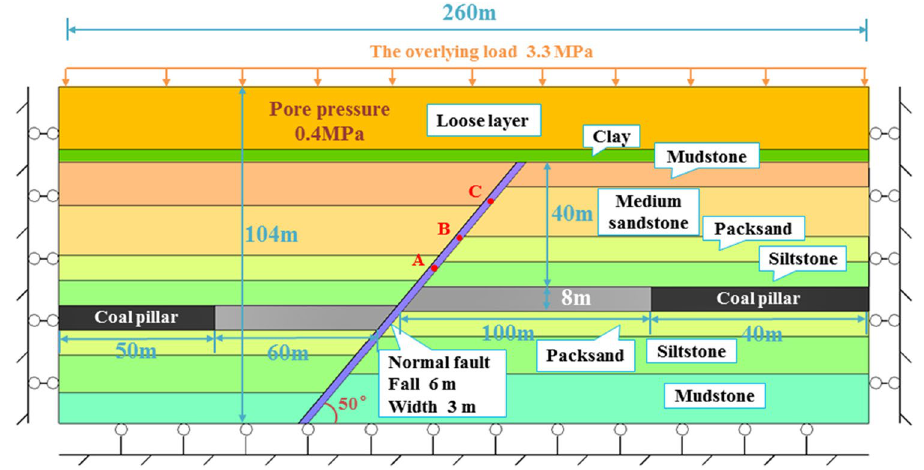
Figure 3. Schematic model of the geological situation at the 331 working face.